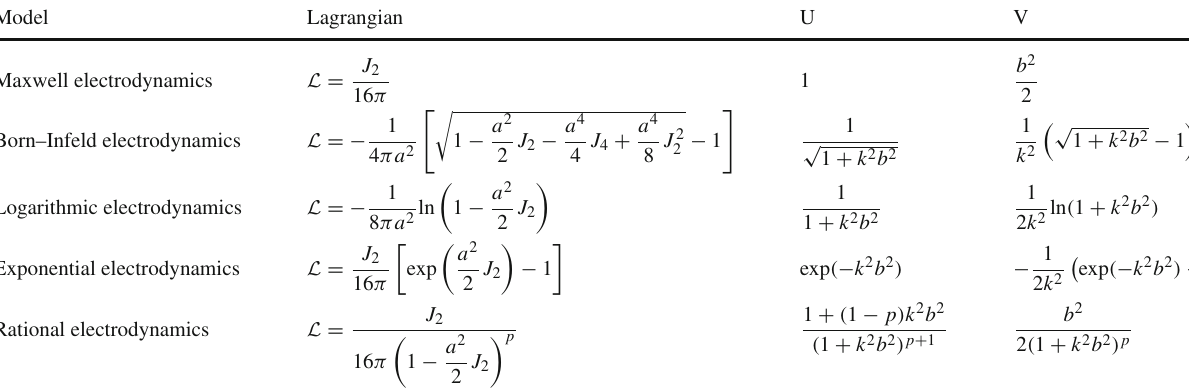
Table 1 Coefficients U and V for some specific models